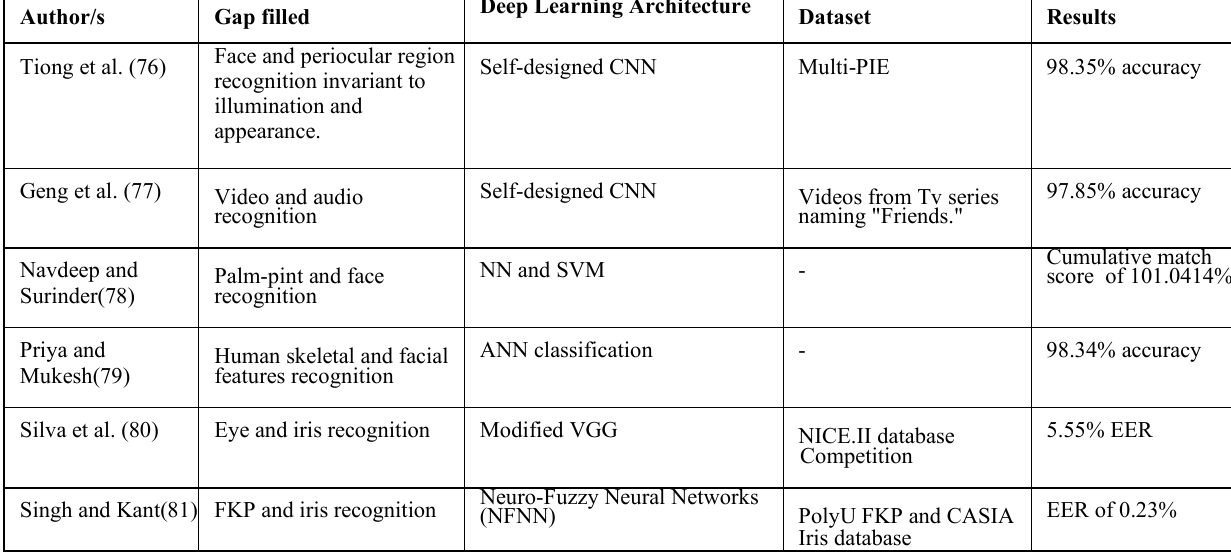
Table 10. Important works on Multimodal Biometrics identification using deep